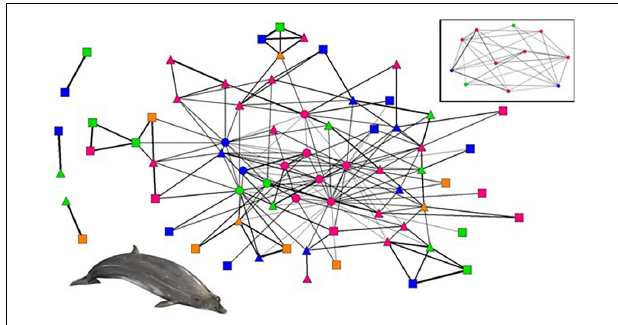
FIGURE 3 | Network diagram of Blainville’s beaked whales. Nodes represent individuals and are coloured and shaped for age-sex class and residency attributes: pink- adult female, blue- adult male, orange- subadult male, green- immature; circle- resident, triangle- visitor, and square- transient. The thickness of the lines between nodes represents the strength of association among dyads, where thicker lines correspond to stronger associations. The embedded network at the top right is the network of the resident whales only. Illustration © ARDITI/E. Berninsone.